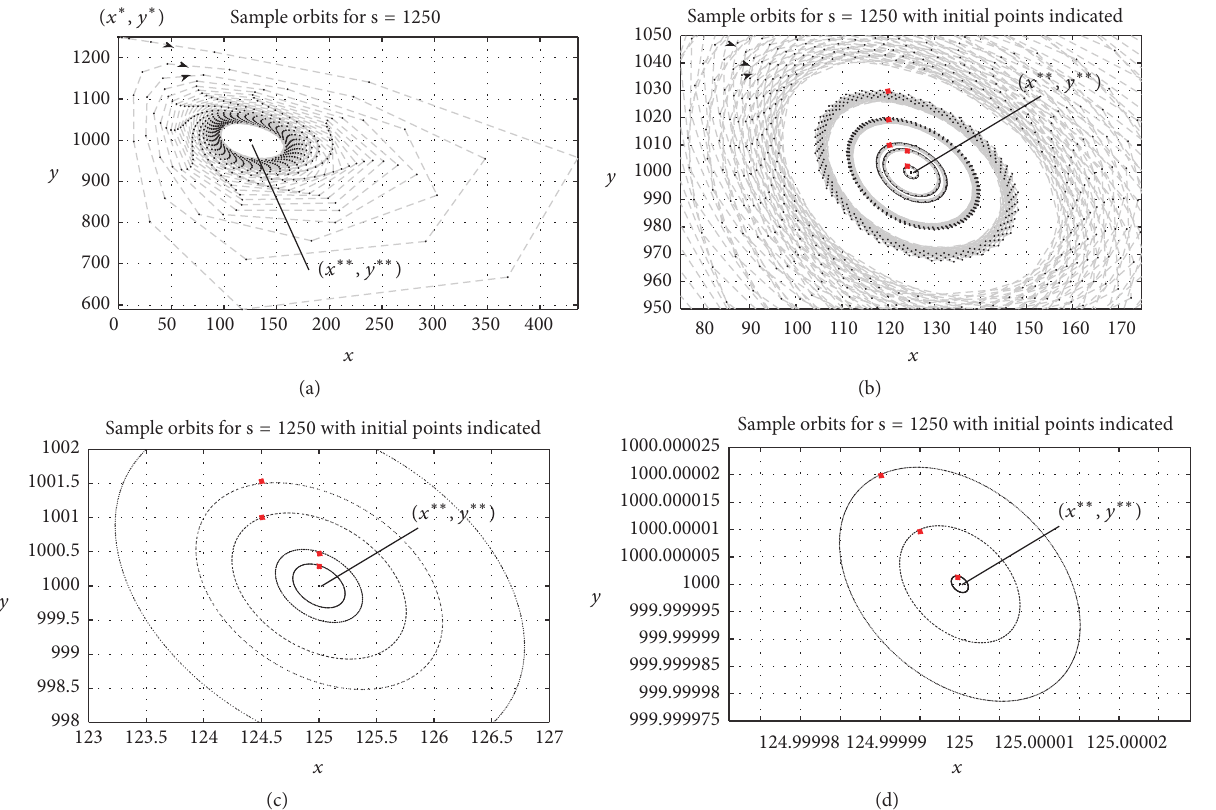
Figure 5: Dynamics of the case 𝑠 = (1 + 𝐴/𝑘)𝑇 with increasing zoom on the equilibrium point (𝑥 ∗∗ ,𝑦 ∗∗ ) .